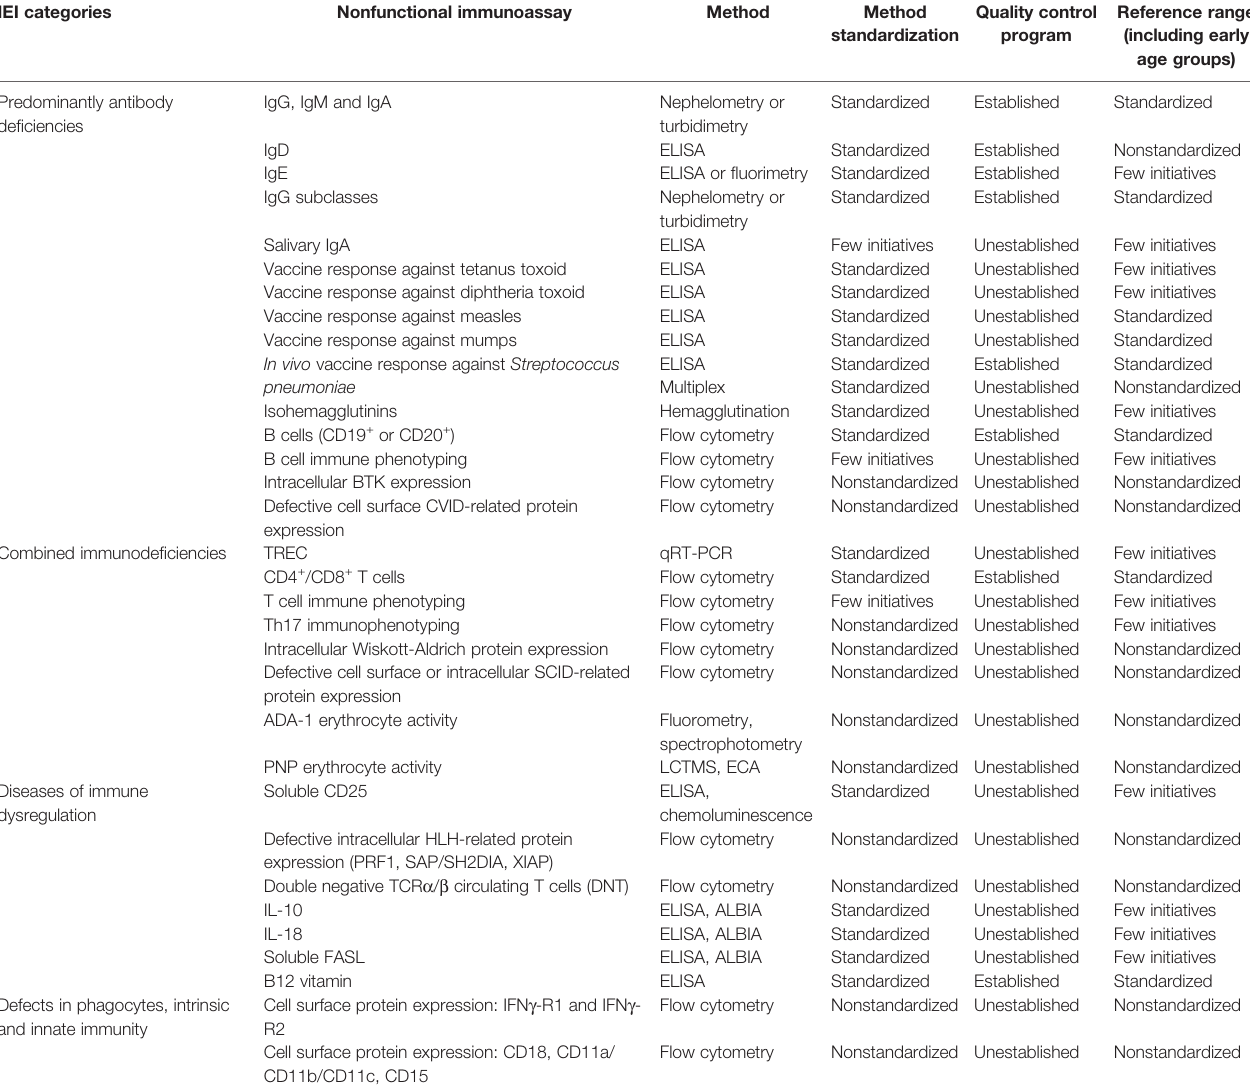
TABLE 6 | Quality and standardization control strati fi cation of inborn errors of immunity (IEI) assessment nonfunctional